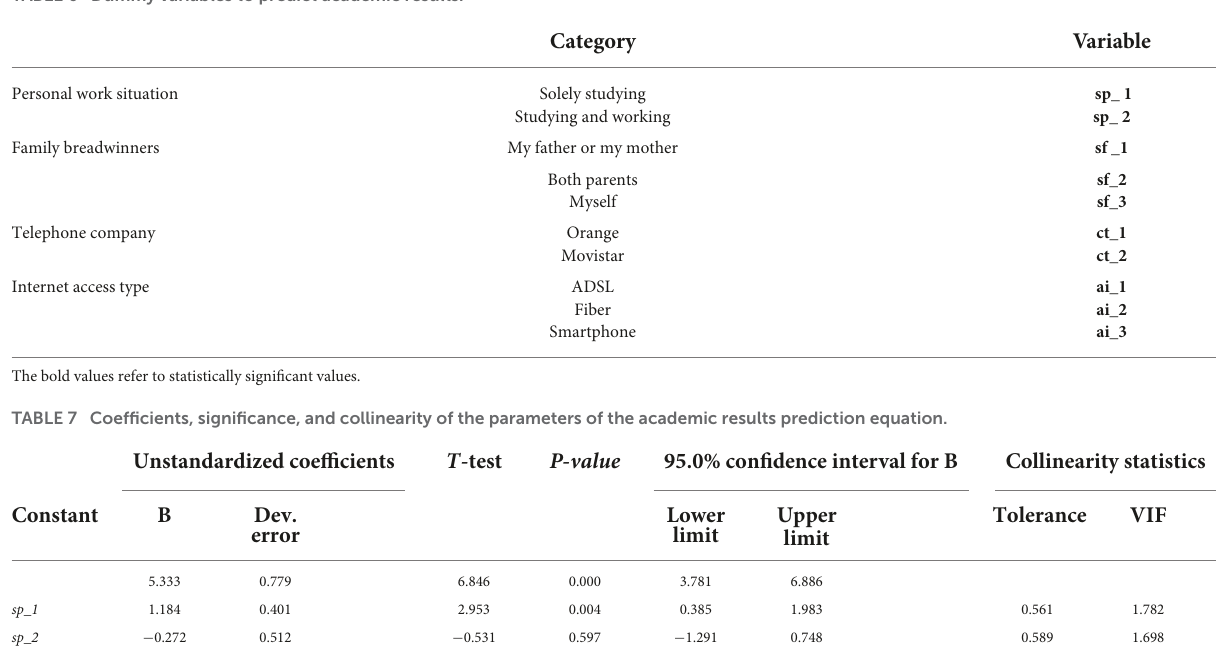
TABLE 6 Dummy variables to predict academic results.